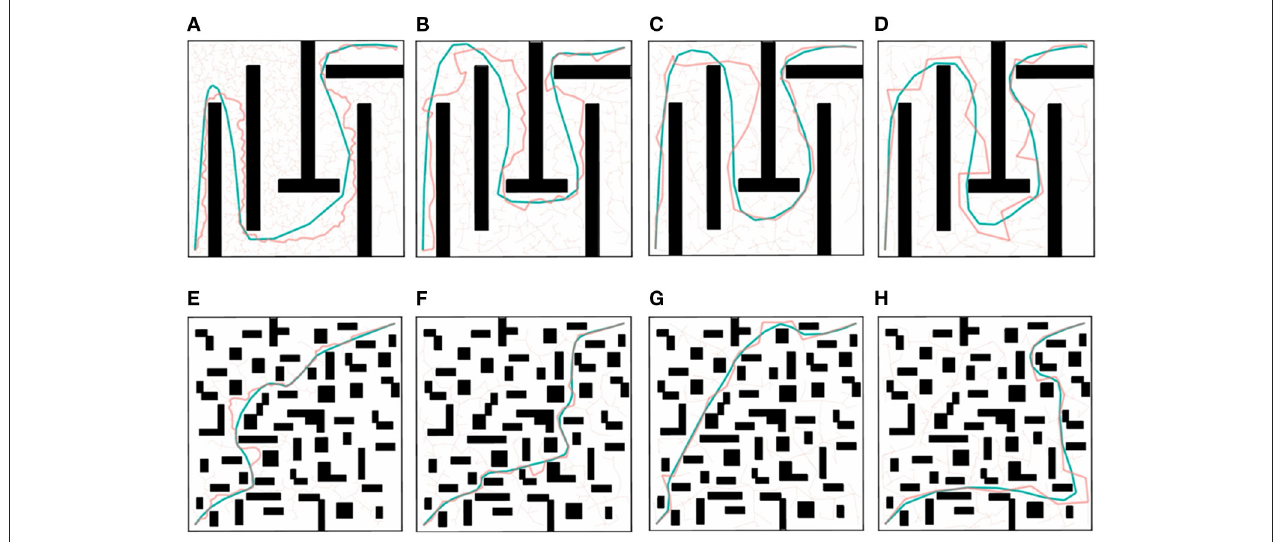
FIGURE 6 | (A) λ = 0.02; (B) λ = 0.05; (C) λ = 0.10; (D) λ = 0.15; (E) λ = 0.02; (F) λ = 0.05; (G) λ = 0.10; (H) λ = 0.15. 2D experiments on a maze-like map (A–D) and a randomly-generated obstacles map (E–H) with different values of the step length λ . The red trajectory is the solution of RRT algorithm, which is a linear polygon path. The blue trajectory is the solution optimized by LCQP.